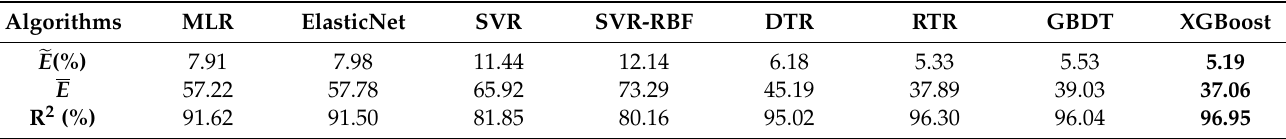
Table 4. Average accuracy of